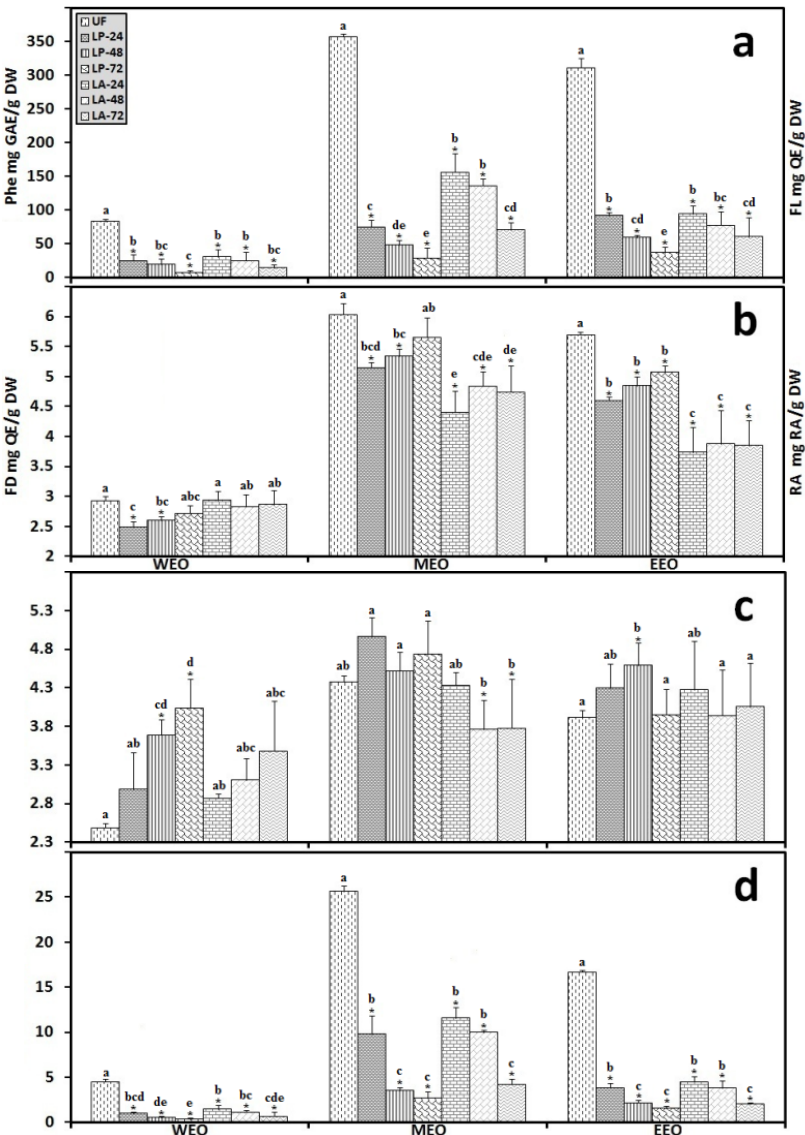
Figure 9. Antioxidant components of IOSC subjected to LSF using three different